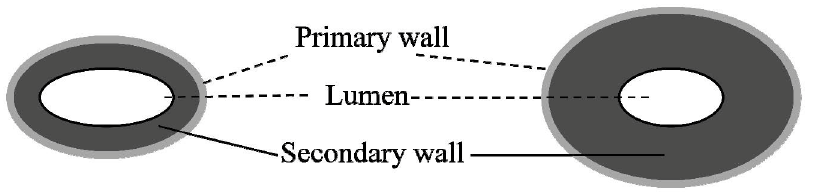
Figure 1. Schematic of immature (left) and mature (right) single fiber